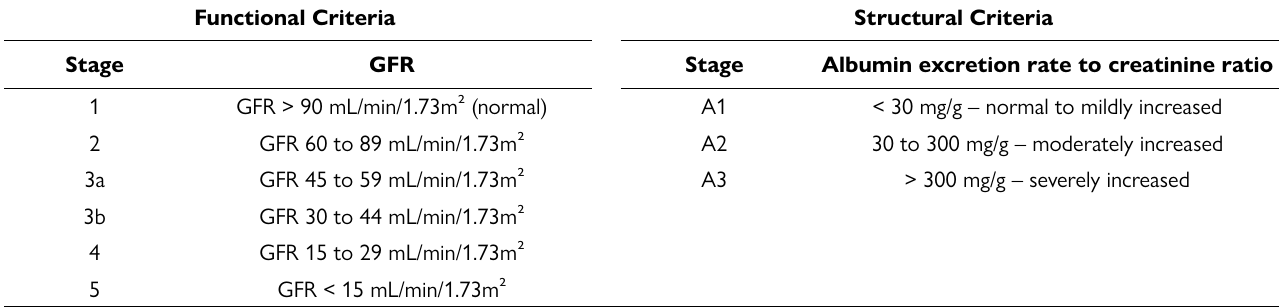
Table 2. Stages of chronic kidney disease (CKD) [38]. Functional